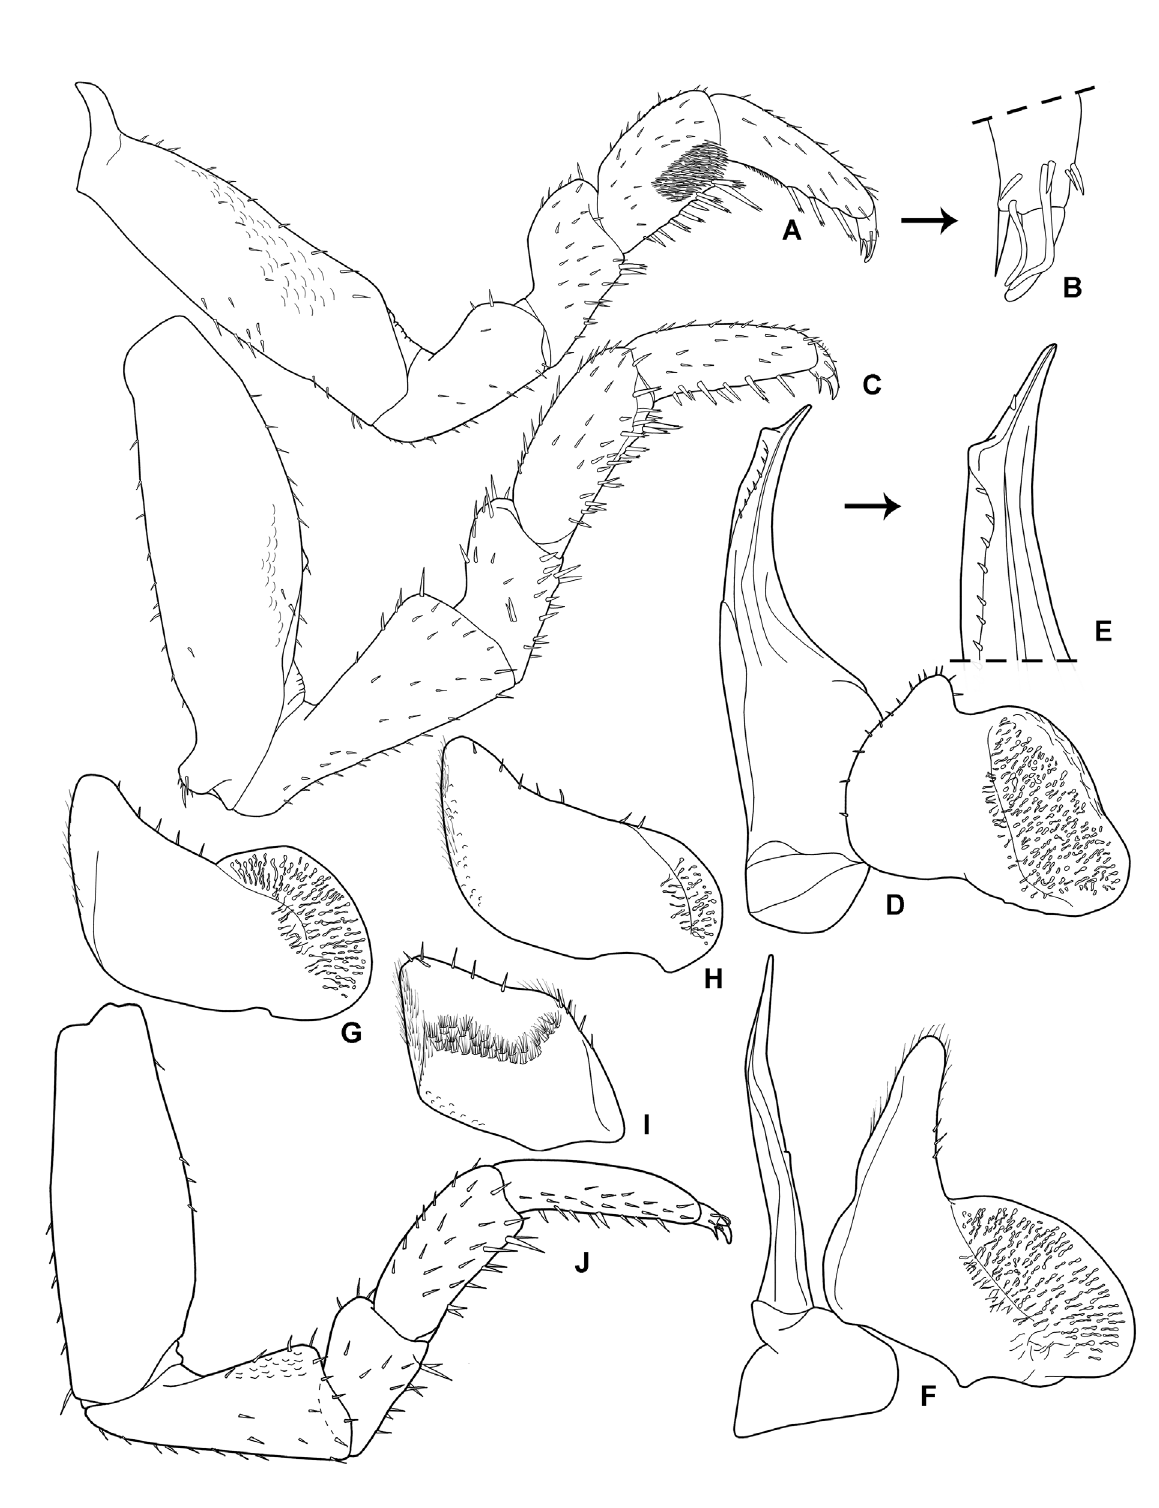
Fig. 2. Brasiloniscus maculatus (Lemos de Castro, 1973) gen. et comb. nov. A–I . Paratype, ♂ (MNRJ 6212) A . Pereopod 1. B . Pereopod 1 dactylus. C . Pereopod 7. D . Pleopod 1. E . Details on pleopod 1 endopod. F . Pleopod 2. G . Pleopod 3 exopod. H . Pleopod 4 exopod. I . Pleopod 5 exopod. J . Paratype, ♀, pereopod